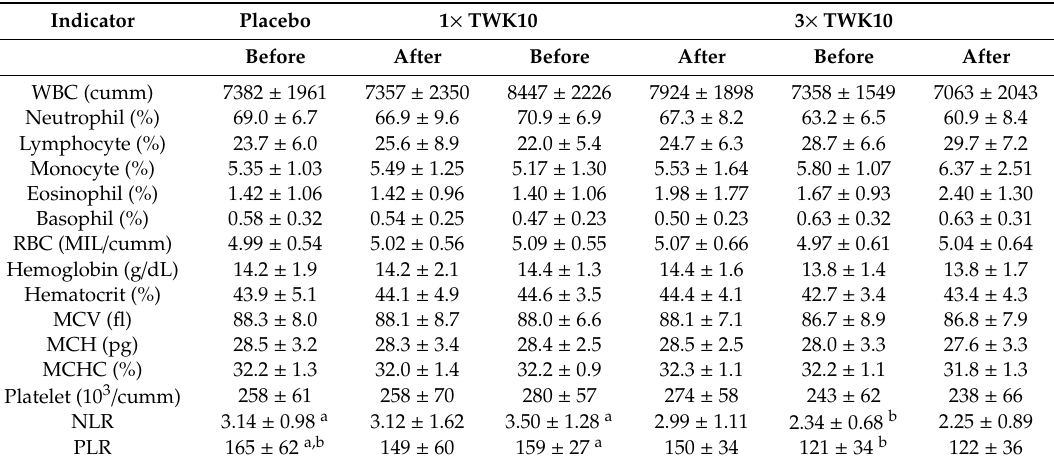
Table 2. Blood count profiles of subjects.